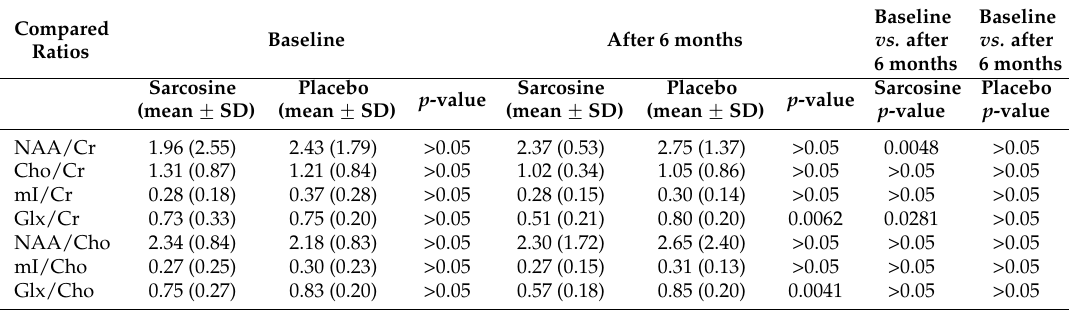
Baseline After 6 months